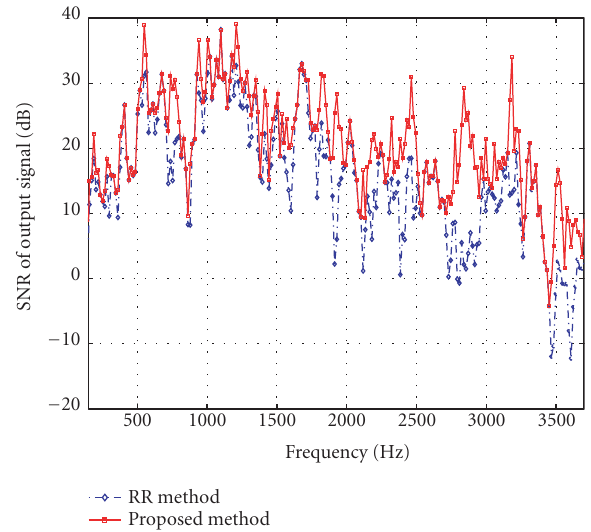
Figure 3: Comparison of the overall system output SNR between RR-GSC and MF-GSC at 0 dB input SNR.